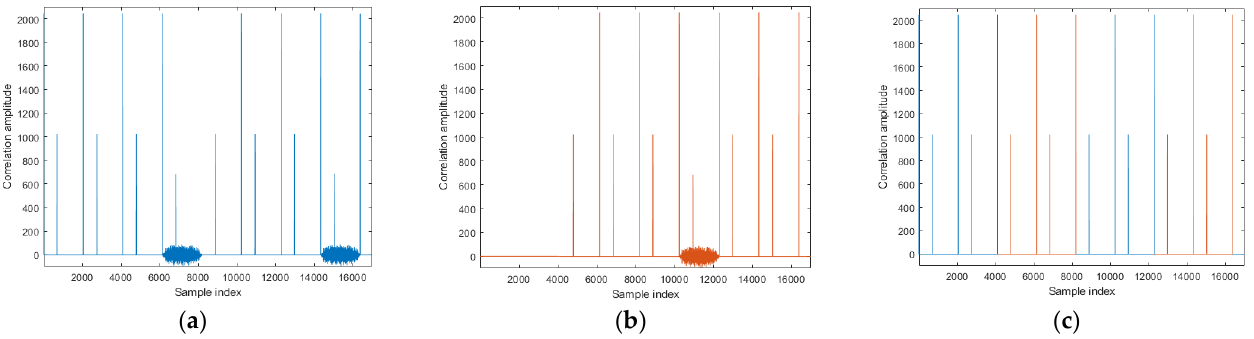
Figure 6. Correlation of a repeating PRBS11 by the method proposed (FFT length = 8192, simulated channel response = δ (n) + 0.5· δ (n − 700)): ( a ) correlation of the periodical sequence without any changes; ( b ) output of a correlator, which is delayed by half an FFT block; ( c ) result after combining both outputs.